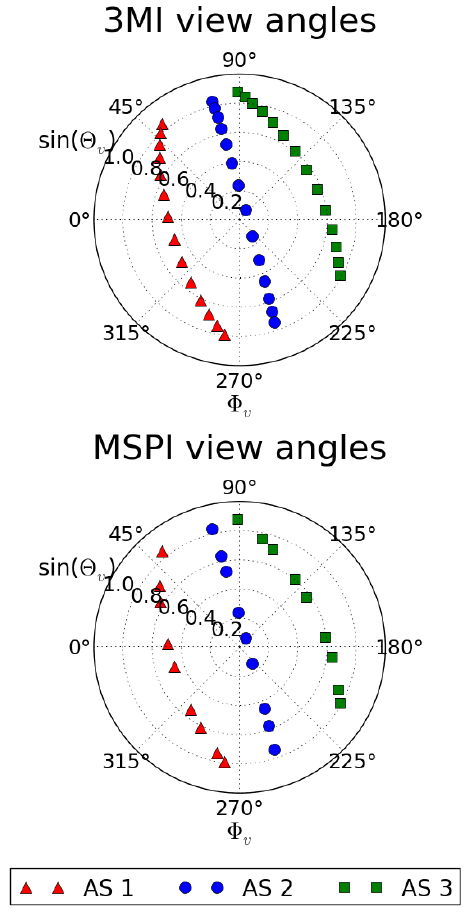
Figure 2. Angular sampling from the choice of MSPI’s and 3MI’s view angles.